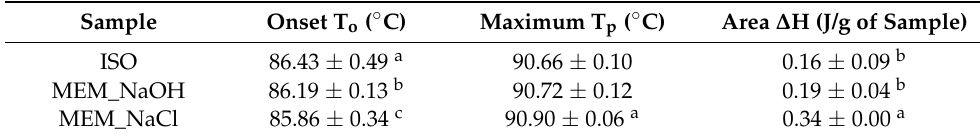
Table 4. Thermal properties of isoelectric pH precipitated isolate (ISO), and membrane isolated pro- teins from alkaline (MEM_NaOH) and salt (MEM_NaCl) solution extracts obtained using differential scanning calorimetry *.